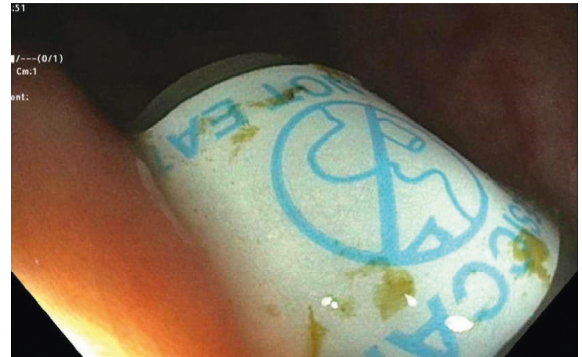
Figure 2: Cylindrical foreign body labeled “DO NOT EAT” in the cecum.